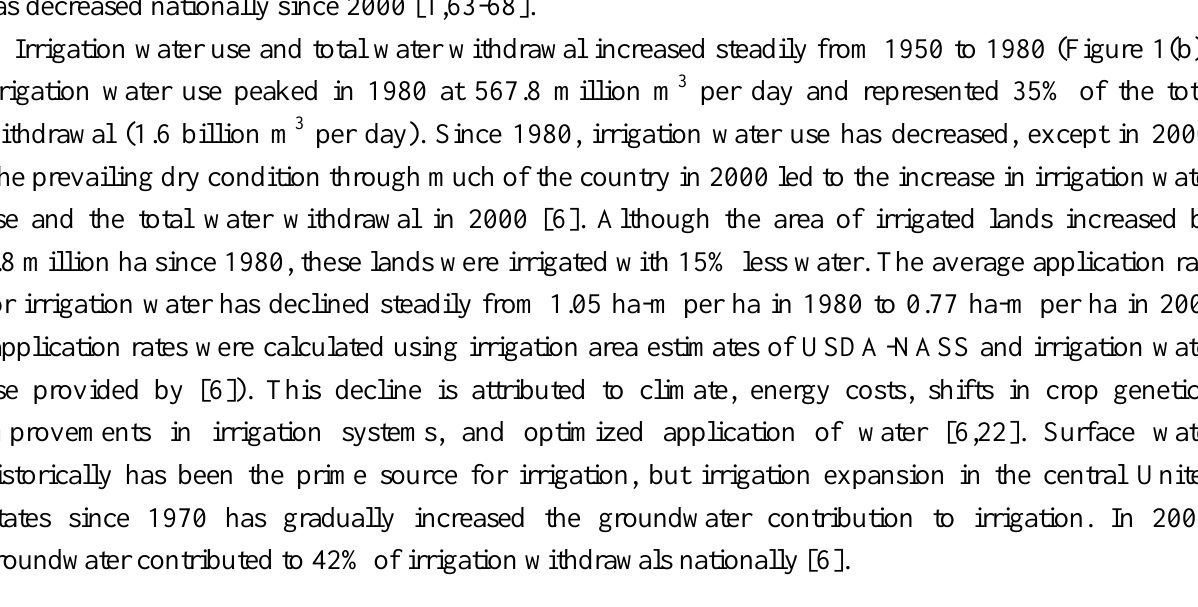
Figure 1. Trends in (a) Population and irrigated lands, and (b) Total water withdrawal and irrigation water use in the United States